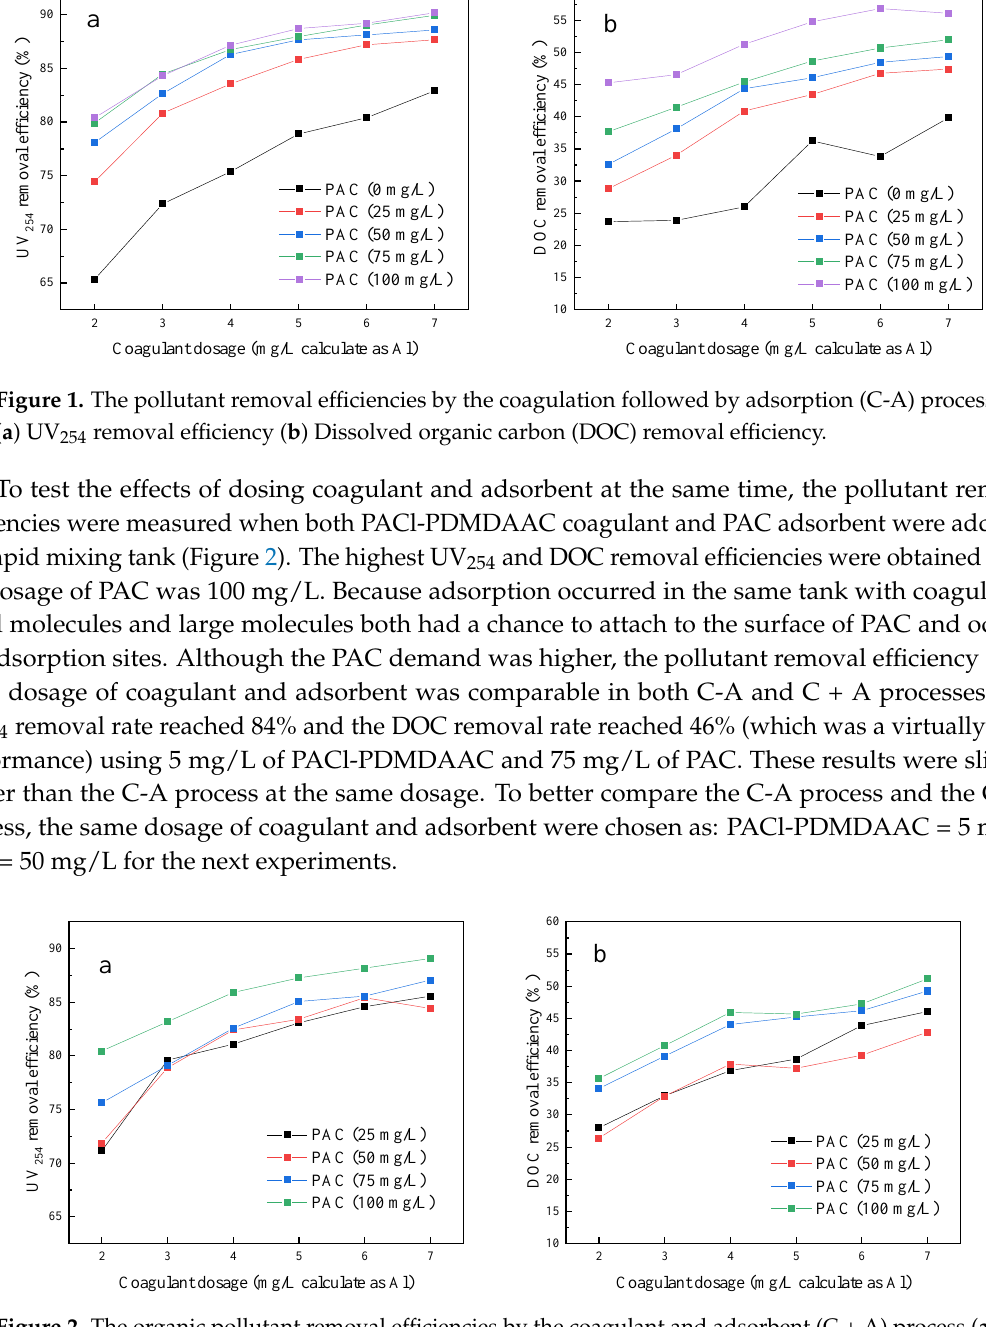
Figure 2. The organic pollutant removal efficiencies by the coagulant and adsorbent (C + A) process ( a ) UV 254 removal efficiency ( b ) DOC removal efficiency.